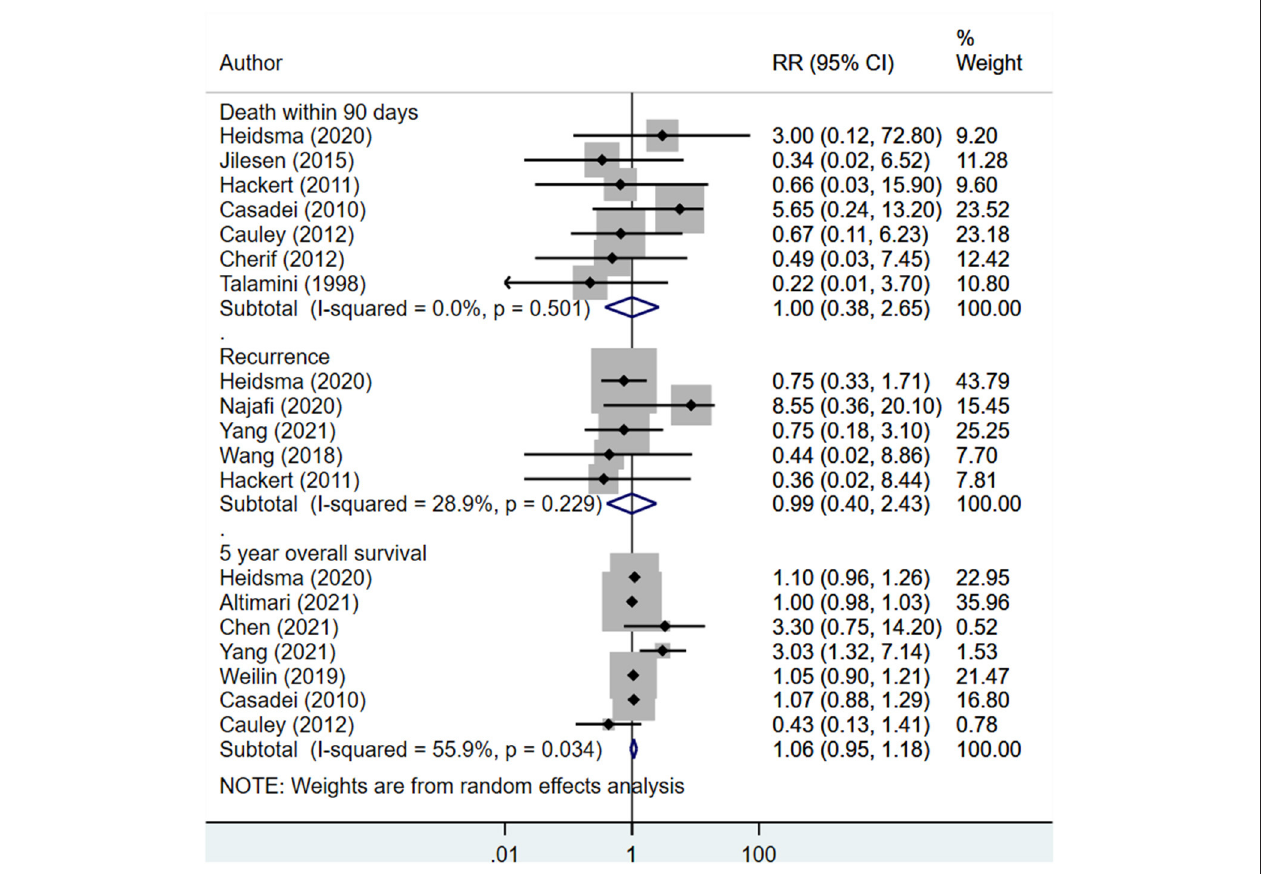
FIGURE 7 | Comparison of risk of recurrence, death within 90 days of operation and 5-years overall survival between enucleation and standard surgical